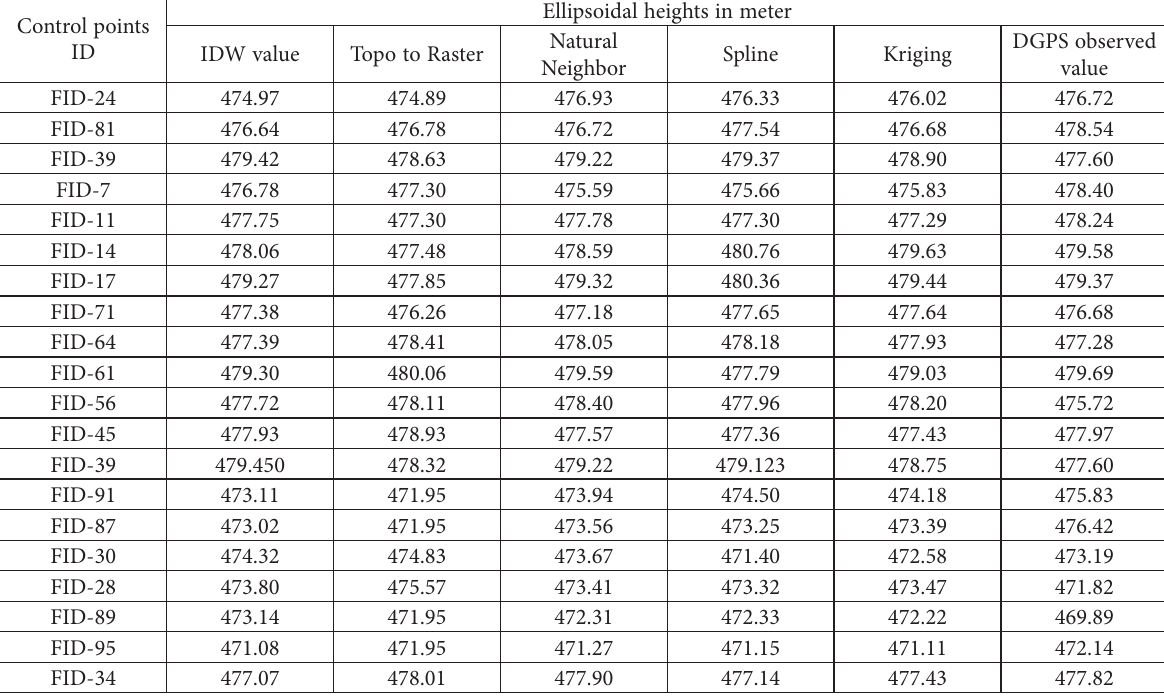
Table 2. Ellipsoidal heights at test GCPs from interpolated and DGPS observed values Control points